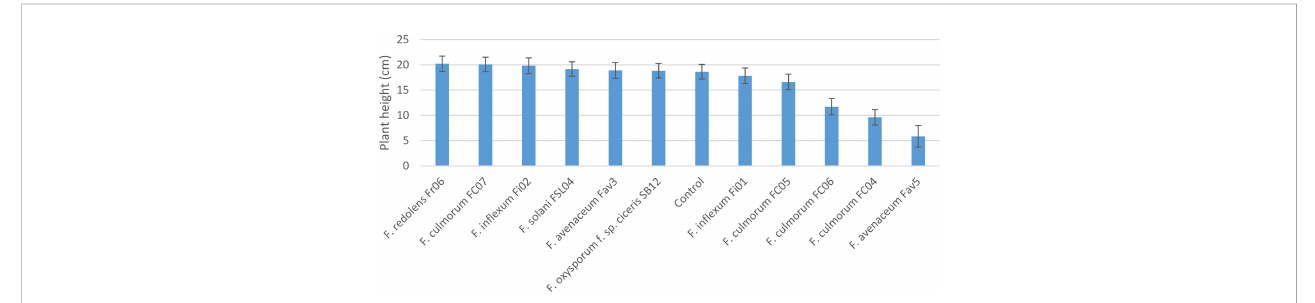
FIGURE 4 Height (cm) of 3-week-old CDC Leader kabuli chickpea inoculated with nine isolates of six Fusarium species under controlled conditions. Inoculum was incorporated into soil at planting and applied by soil drenching 10 days after